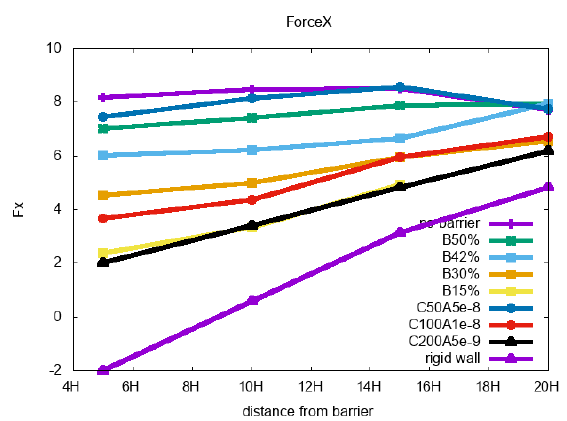
Fig. 6. Regime 1570, the force acting on the body in the dis- tance 5 H ,10 H ,15 H ,20 H behind the barrier with porosity 50%, 42%,30%,15% and height H